Question: Sum up the contents of this chart in one sentence.
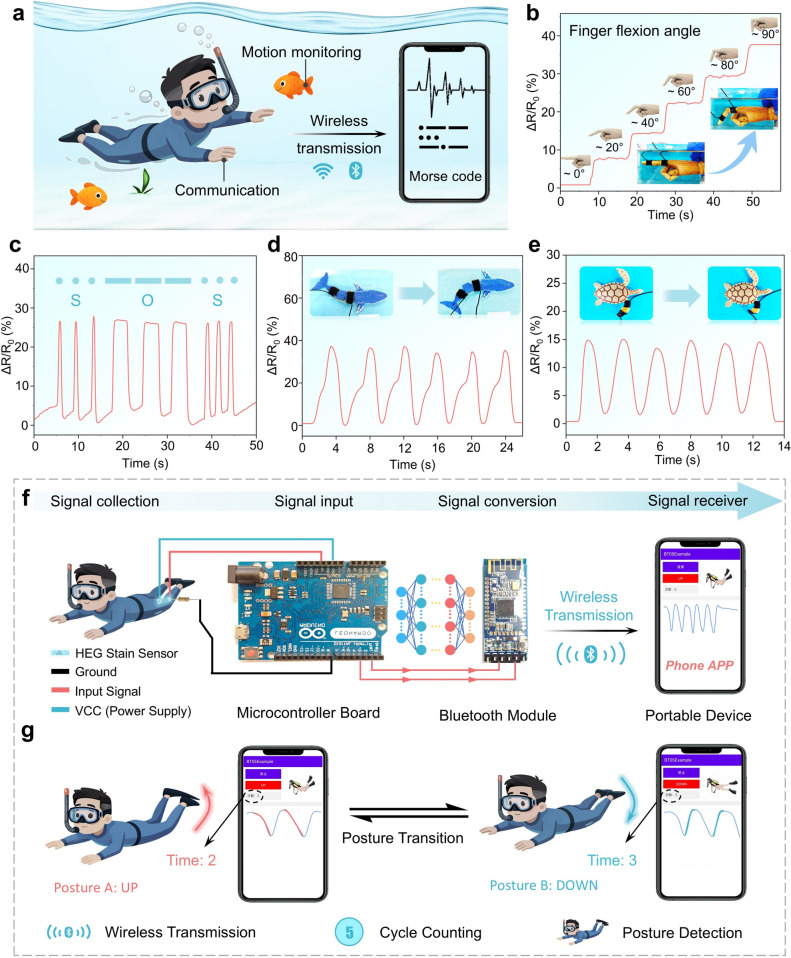
Answer: Underwater communication and motion monitoring applications of DPF-Zn@LNP-HEG. a Schematic for underwater communication and motion monitoring applications. b Real-time Δ R / R 0 versus finger bending angles. c Real-time Δ R / R 0 for the Morse code signals of “SOS”. Δ R / R 0 recorded from the sensor attached to the d robotic whale and e turtle models. f Operation and principle of the human–computer interactive swimming posture detection system. g Real-time monitoring and counting of swimming motions via the wireless sports assistant system